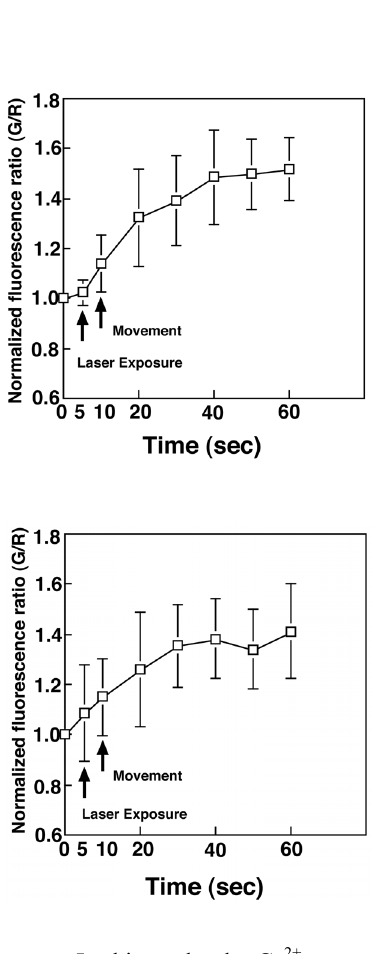
Fig. 3 Changes of intracellular Ca 2+ concentration in stimulated ECs as indicated with normalized fluorescence ratio of Fluo-4 and Fura-red, with movement of the laser spot focused on the nucleus (a), and without movement of the laser spot (b).